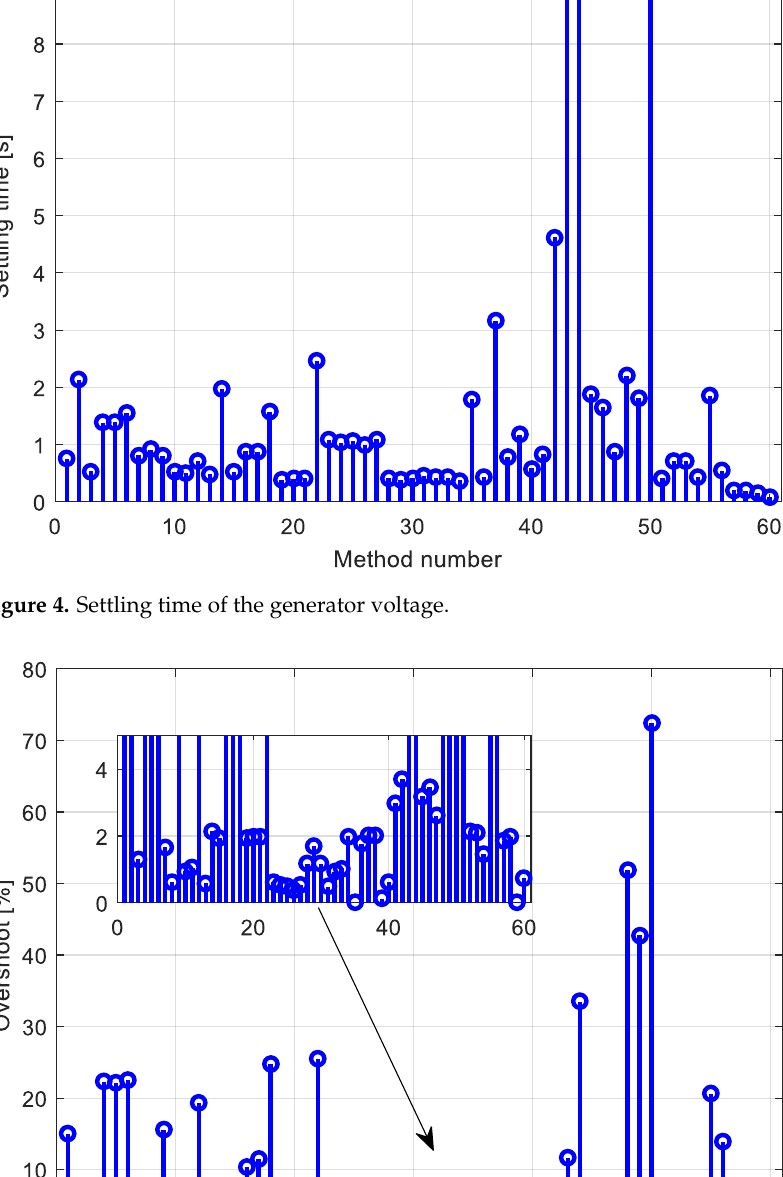
Figure 3. Delay time of the generator voltage.